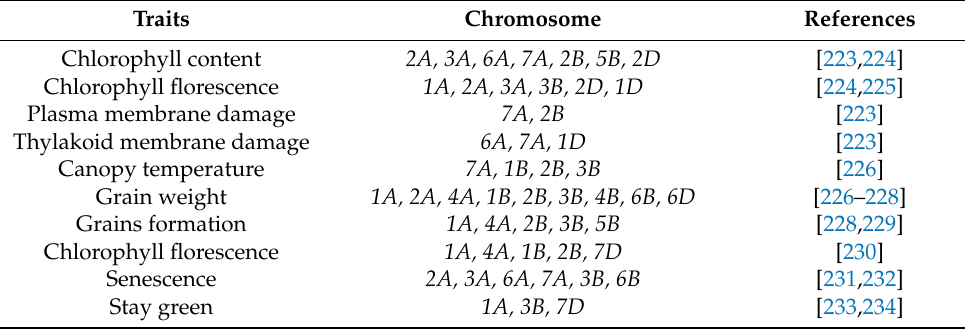
Table 4. Major quantitative trait loci (QTL) identified for traits against heat